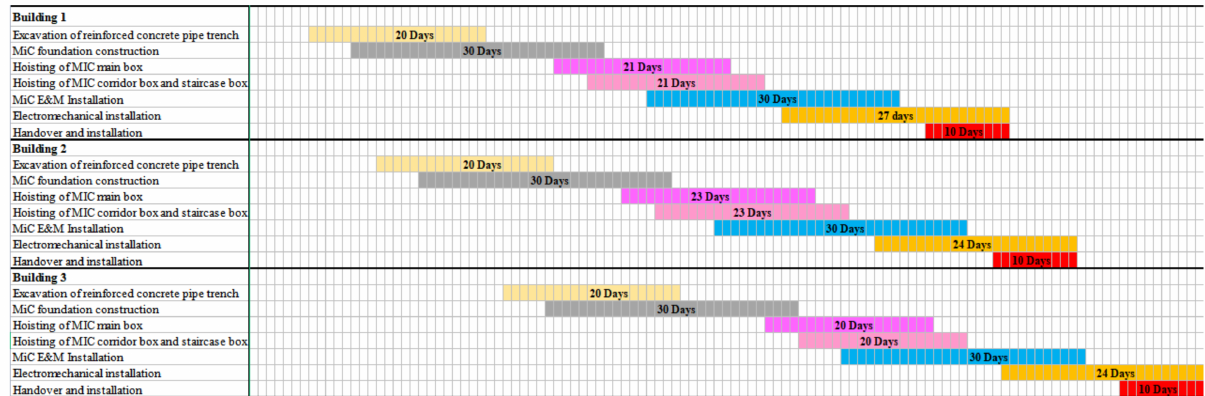
Figure 6. MiC Installation Schedule.